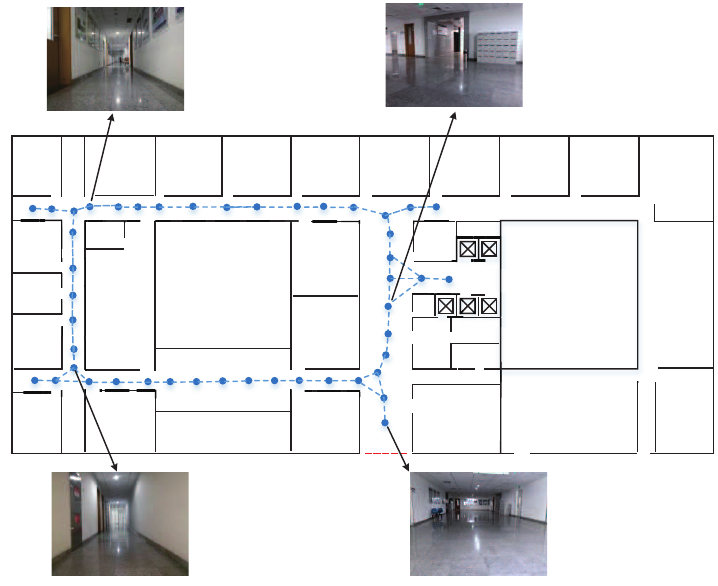
Figure 7. The plan of the experimental